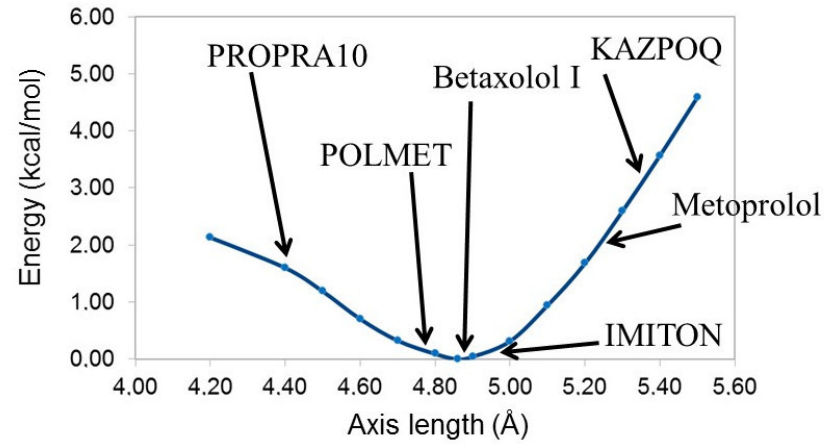
Figure 5. Energy variation for the simplified model 1 . Arrows indicate the axis length for the given structure.